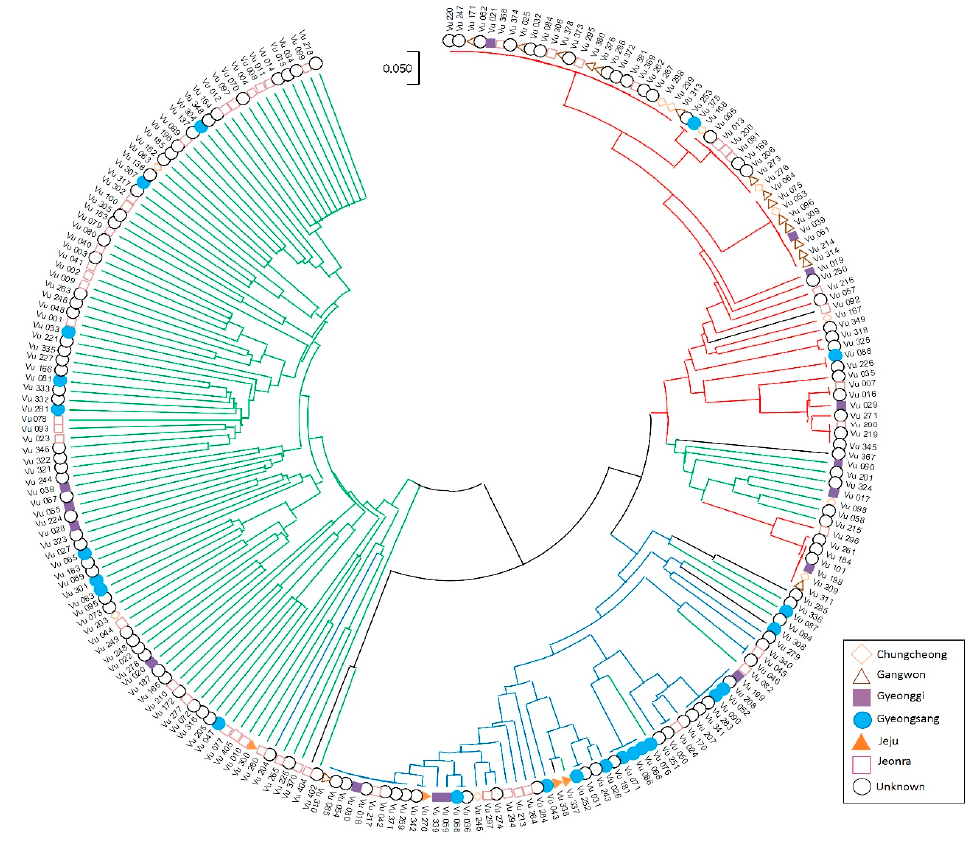
Figure 5. Neighbor-joining tree of the 229 Korean cowpea accessions using MEGA X. The varieties in each colored branch are represented based on the structure population (Q1, green; Q2, red; Q3, blue; admixture, black).